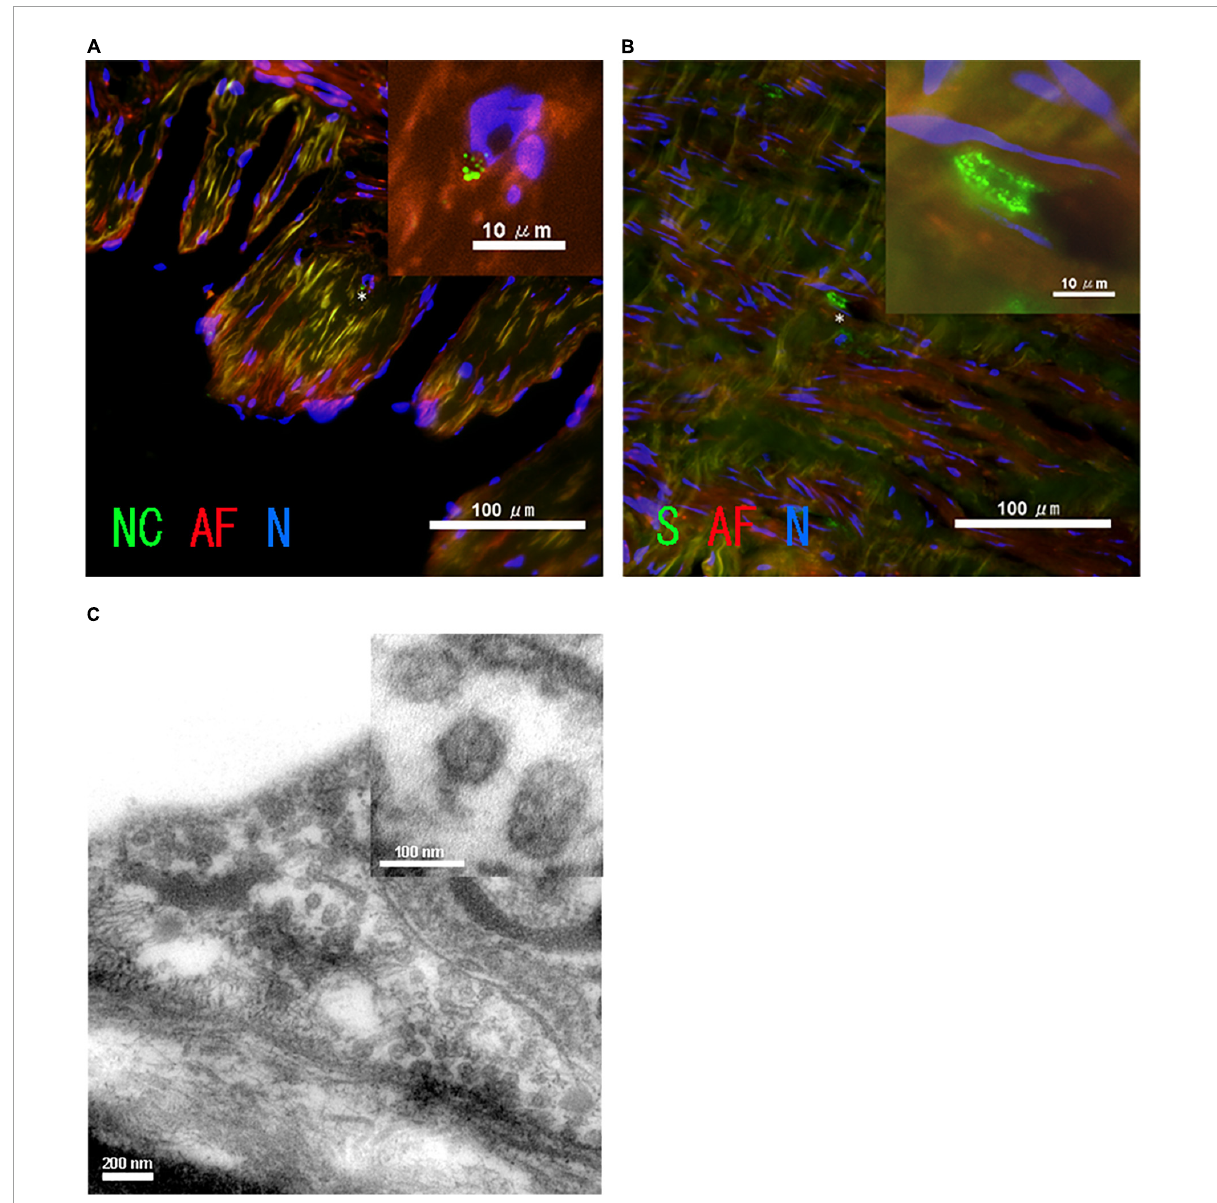
FIGURE3 Images of SARS-CoV-2 in the patient’s saphenous vein. Immunohistochemistry of the saphenous vein of (A) SARS-CoV-2 nucleocapsid, NC (green), and (B) spike, S (green). The asterisk in A indicates the position of the enlarged image shown in the inset. Autofluorescence, AF (red), and nuclear staining with DAPI, N (blue), are also shown. (C) Image of transmission electron microscopy of saphenous